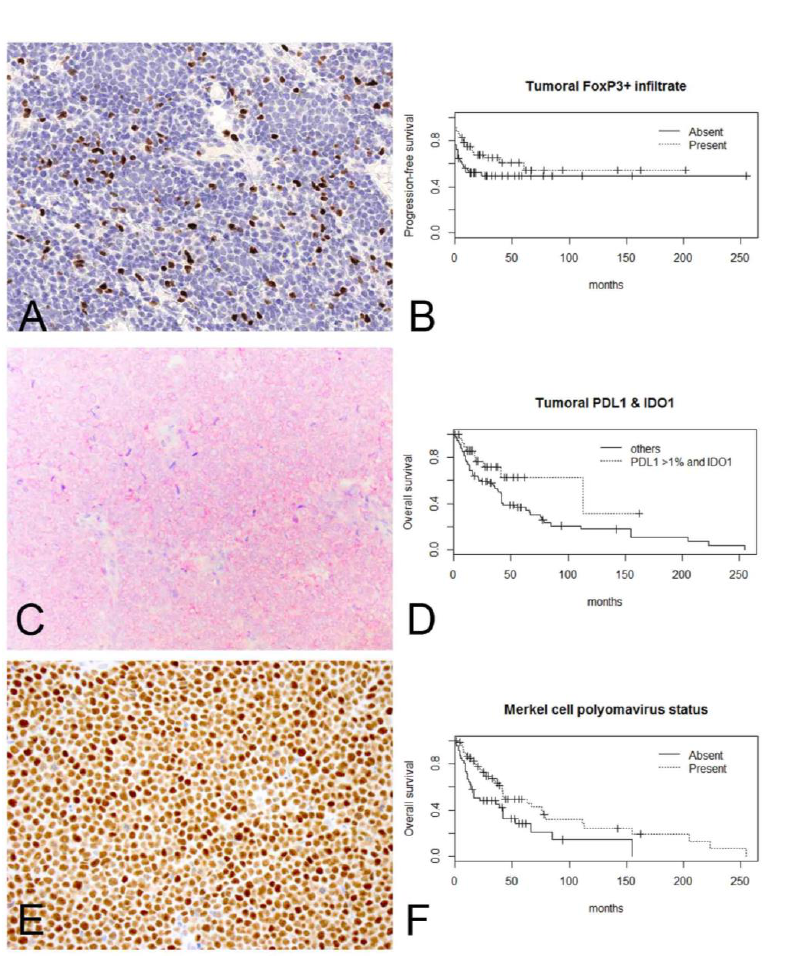
Figure 2. Kaplan–Meier curves demonstrate significant correlation between ( A ) intratumoral FoxP3+ lymphocytes (20 × ) and ( B ) improved progression-free survival (log-rank p = 0.044); ( C ) combined tumoral PD-L1 >1% and high IDO1 expression (40 × ) and ( D ) improved overall survival (log-rank p = 0.052); ( E ) nuclear expression of Merkel cell polyomavirus large T-antigen (40 × ) and ( F ) improved overall survival (log-rank p = 0.0066).